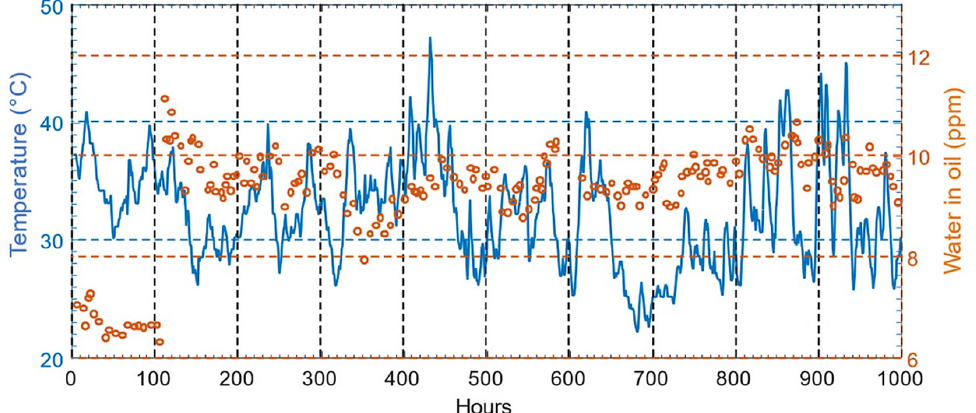
Figure 35. Evolution of temperature (blue) and oil (orange) water content.